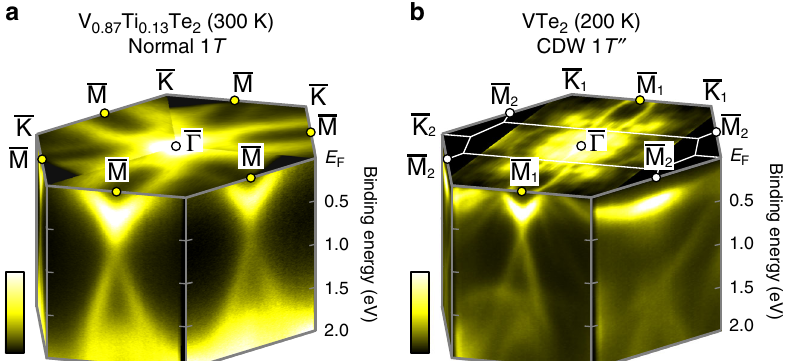
Fig. 2 Overview of Fermi surface and band dispersions for normal 1 T and CDW 1 T ″ phases. a Bird ’ s eye ARPES image of 1 T -V 0.87 Ti 0.13 Te 2 (300 K, h ν = 21.2 eV). b Same as a , but for 1 T ″ -VTe 2 (200 K, h ν = 90 eV).